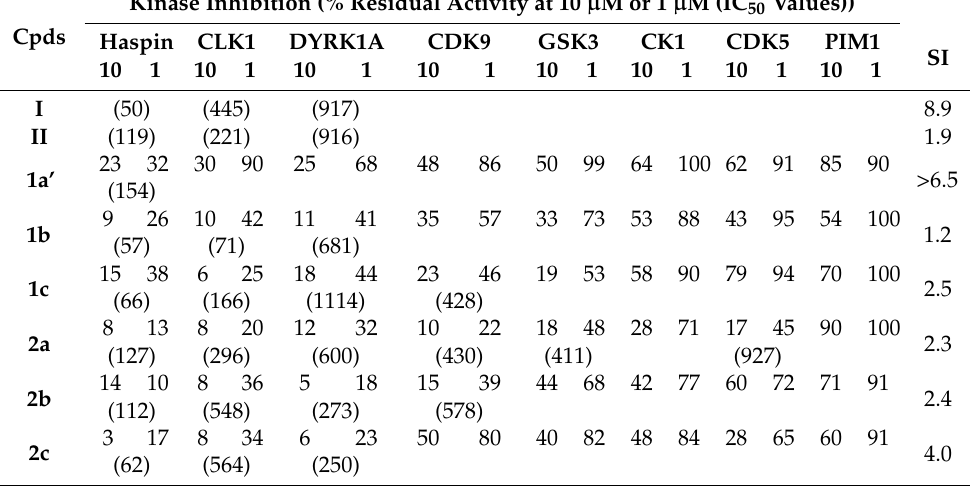
Table 1. Percentage of kinase residual activity at 10 µ M and 1 µ M compound concentrations ( 1a’ , 1b – 1c , 2a – 2c ). IC 50 values in nM (given in parentheses) were determined for Haspin when residual activity was <50% at 1 µ M. For other kinases, IC 50 values were measured for most inhibited ones (% Inhibition ≥ 50% at 1 µ M). For compounds I , II , 1b , 1c and 2a , Selectivity Index (SI) Haspin vs. CLK1 = CLK1 IC 50 /Haspin IC 50 . For compounds 2b and 2c , SI was calculated for Haspin vs. DYRK1A, which was more inhibited than CLK1. For 1a’ , SI was estimated to be >6.5 in regard to Haspin IC 50 value, and CLK1/DYRK1A IC 50 values were assumed to be >1 µ M on the basis of % of inhibition at 1 µ M (less than 50% for CLK1/DYRK1A). Assays were performed in duplicate using the ADP-Glo assay in the presence of 10 µ M ATP. Typically, the standard deviation of single data points was <10%. Compounds I and II IC 50 values from reference [2]. Kinase Inhibition (% Residual Activity at 10 µ M or 1 µ M (IC 50 Cpds